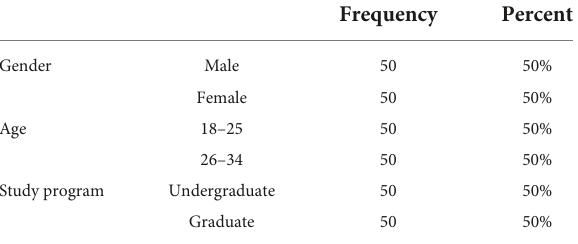
TABLE 1 Demographics of study participants. TABLE 2 Reliability